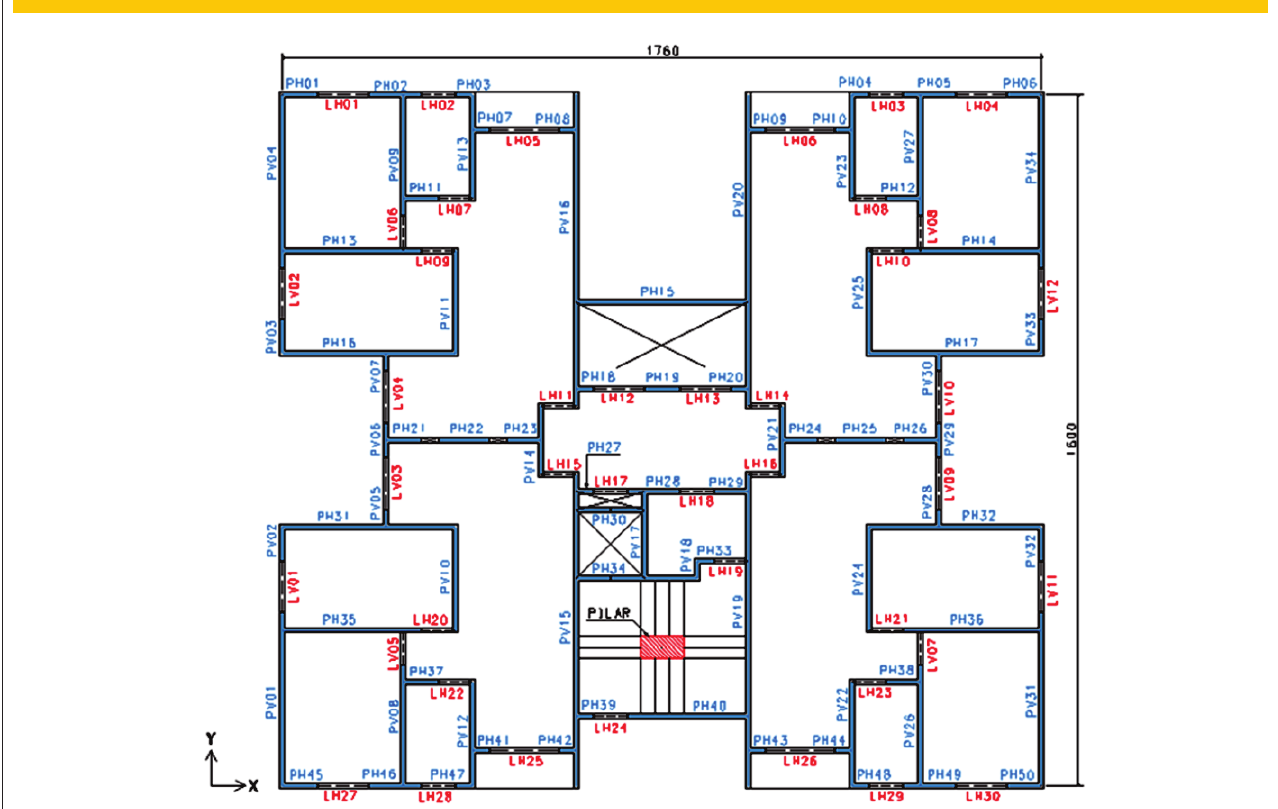
Figure 2 – Type floor plan of the study case: geometry (cm) and names of walls and